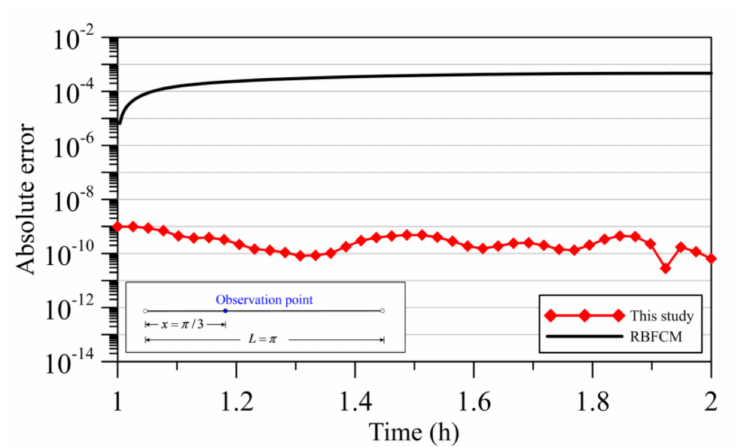
Figure 8. Absolute error at observation point through